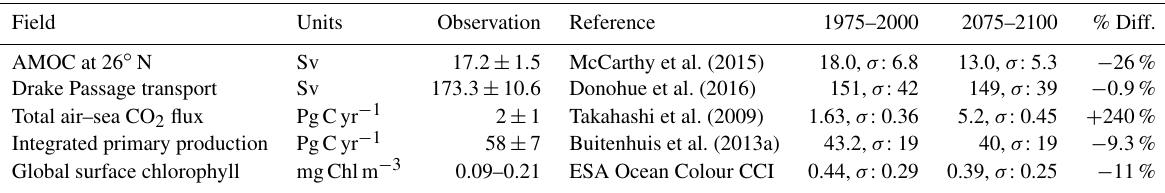
Figure 16. The global mean chlorophyll concentration for the surface layer of a range of CMIP5 models. Table 1. Summary table showing the multi-model mean and standard deviation of the five fields. After the field and units columns, the observational range, measurement uncertainty, and reference are shown. The fifth column shows the multi-model mean of years 1975–2000 and the standard deviation ( σ ) in the historical simulation. The sixth column shows the multi-model mean of years 2075–2100 and the standard deviation in the RCP8.5 simulation. The final column (% Diff.) shows the percentage of difference between the first period and the second